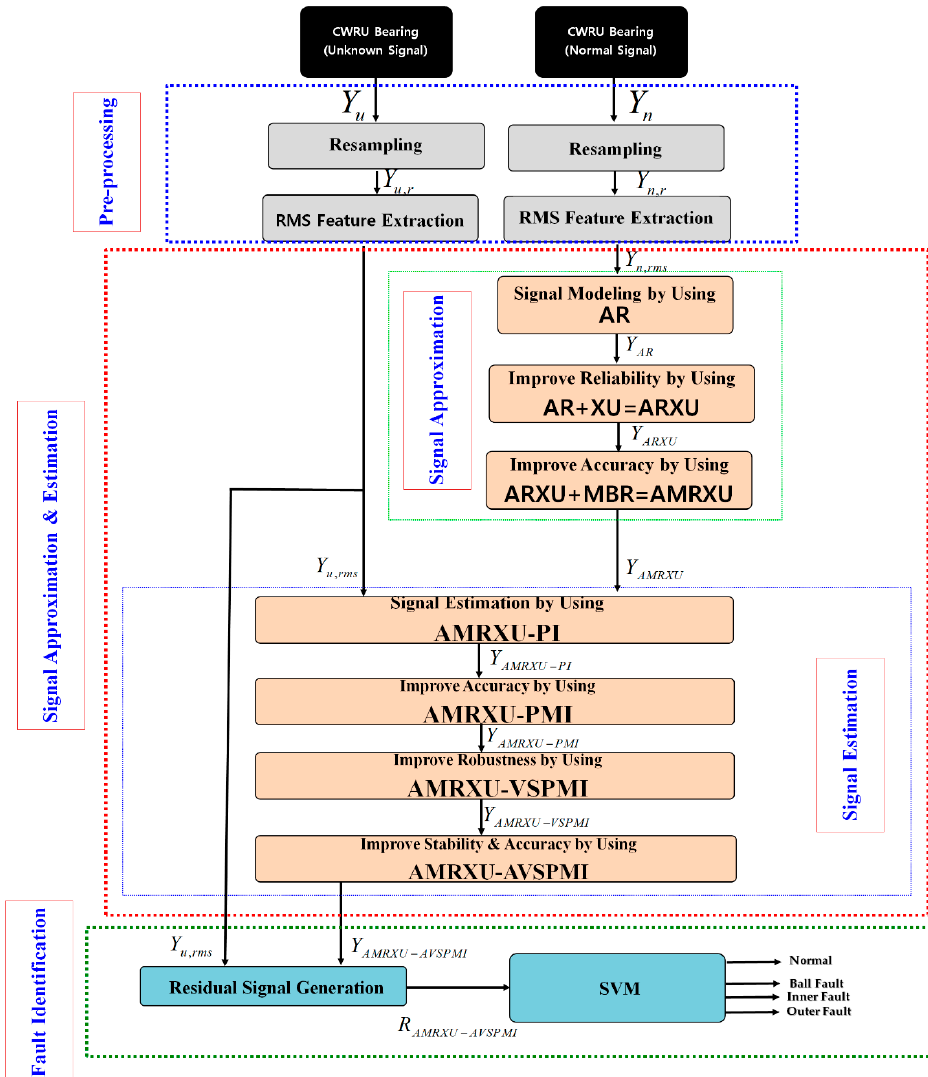
Figure 1. The proposed scheme for fault diagnosis of bearing based on three stages: preprocessing, signal approximation and estimation, and fault classification.